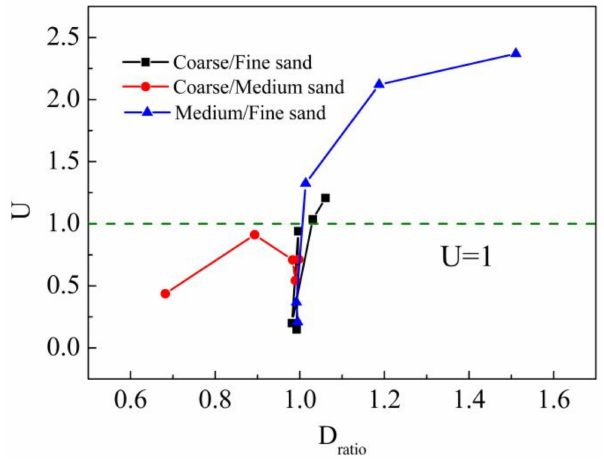
Figure 9. Relationship between the transmission uniformity control coefficient and hydraulic conduc- tivity decrease